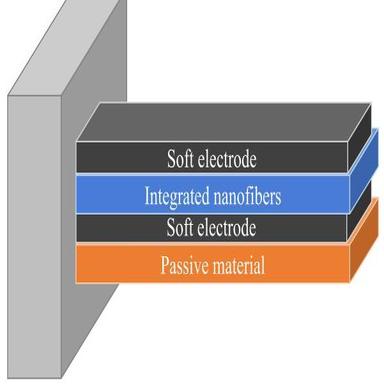
The soft actuators as a composite unimorph cantilever beam.